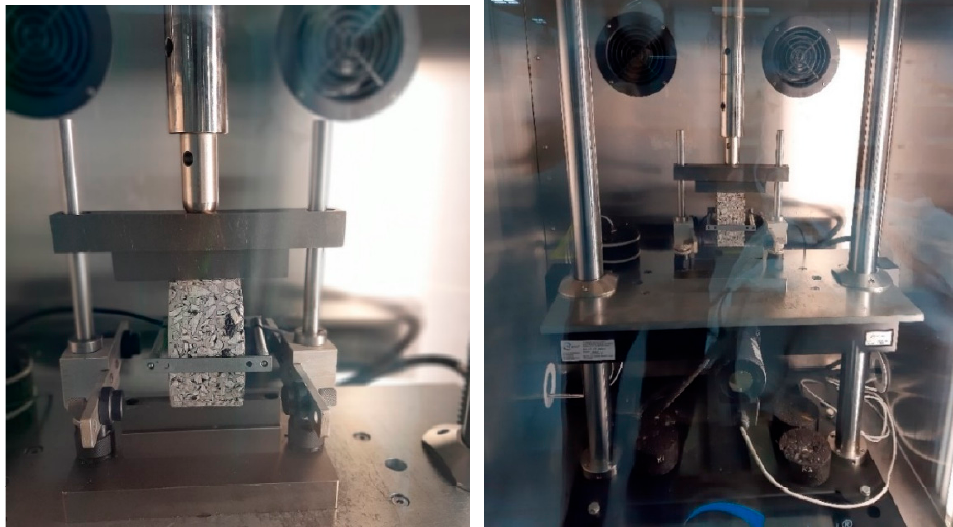
Figure 4. Sample position for the ITFT testing.